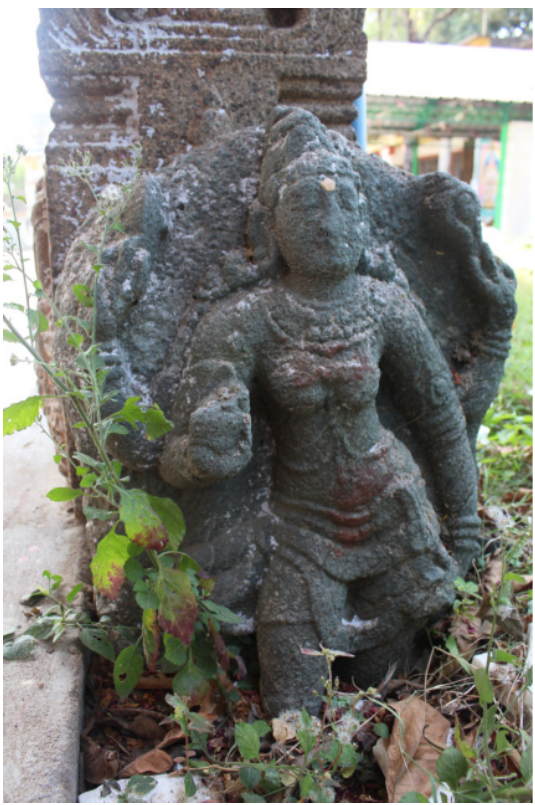
Figure 14. Durga, Murugan temple garden, Uttiramerur, Tamil Nadu. Photograph by Emma Na- talya